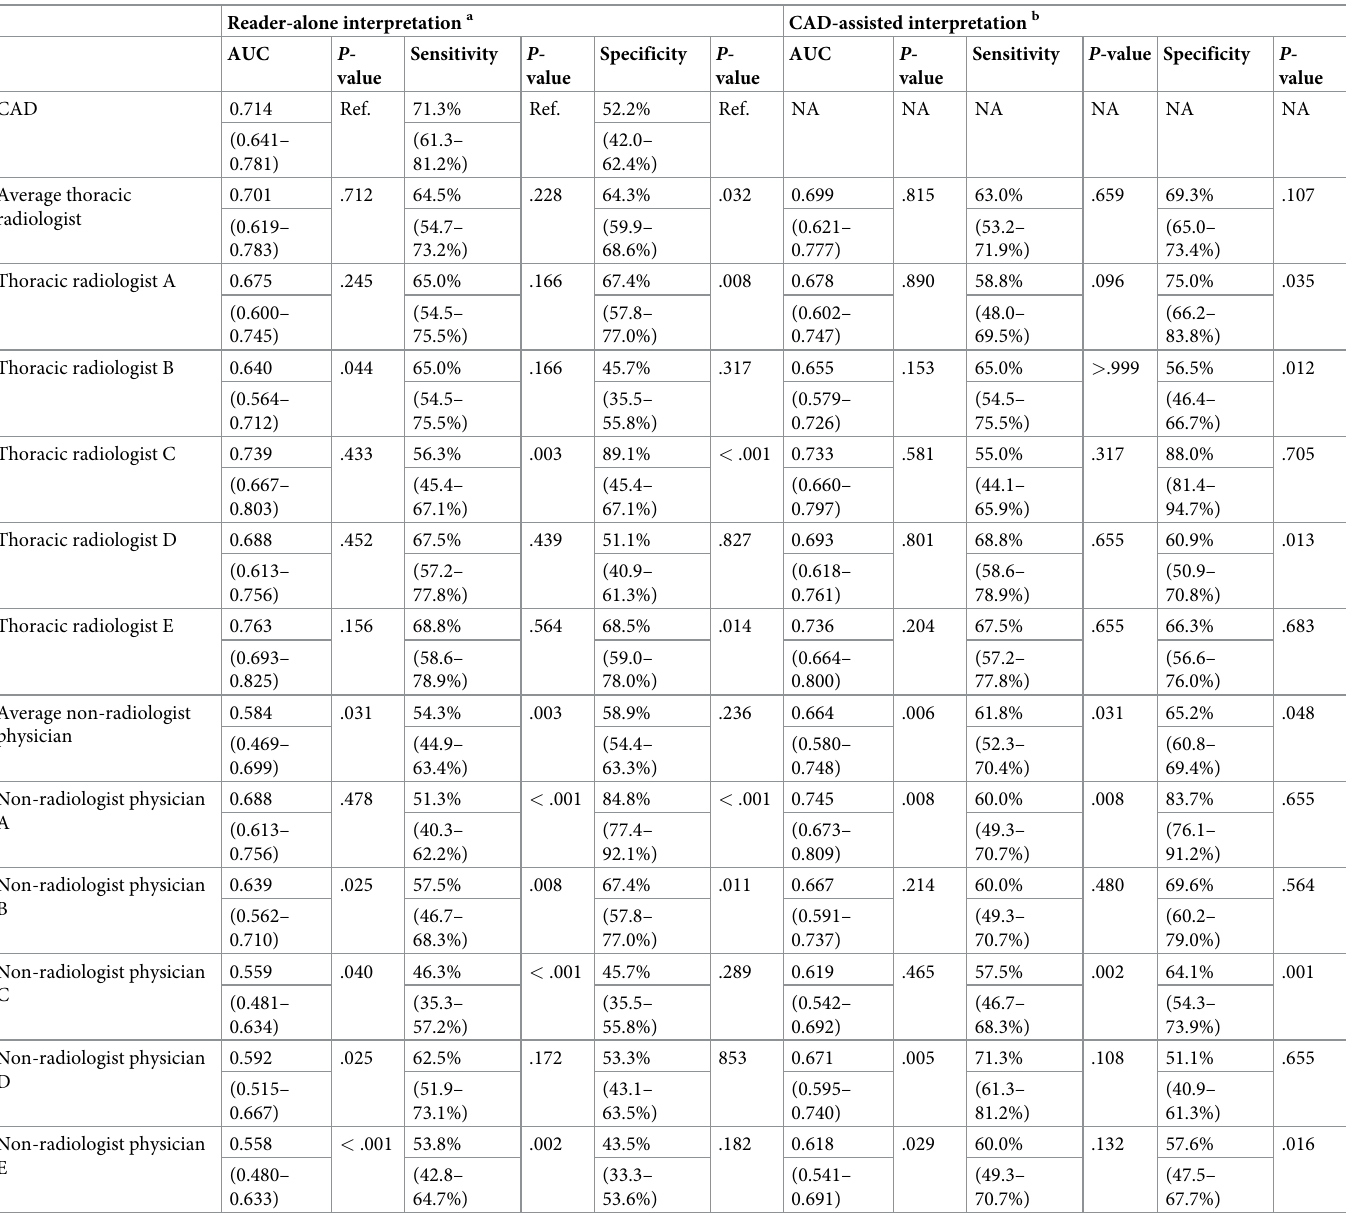
Table 2. The CAD and physician’s performances with reference standard of diagnosis of COVID-19 by RT-PCR. Reader-alone interpretation